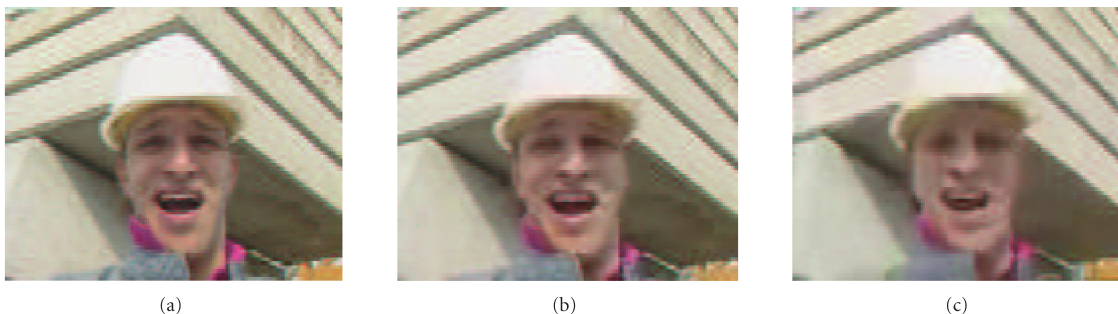
Figure 3: An integrated cross-layer framework of multimedia communications over multihop wireless